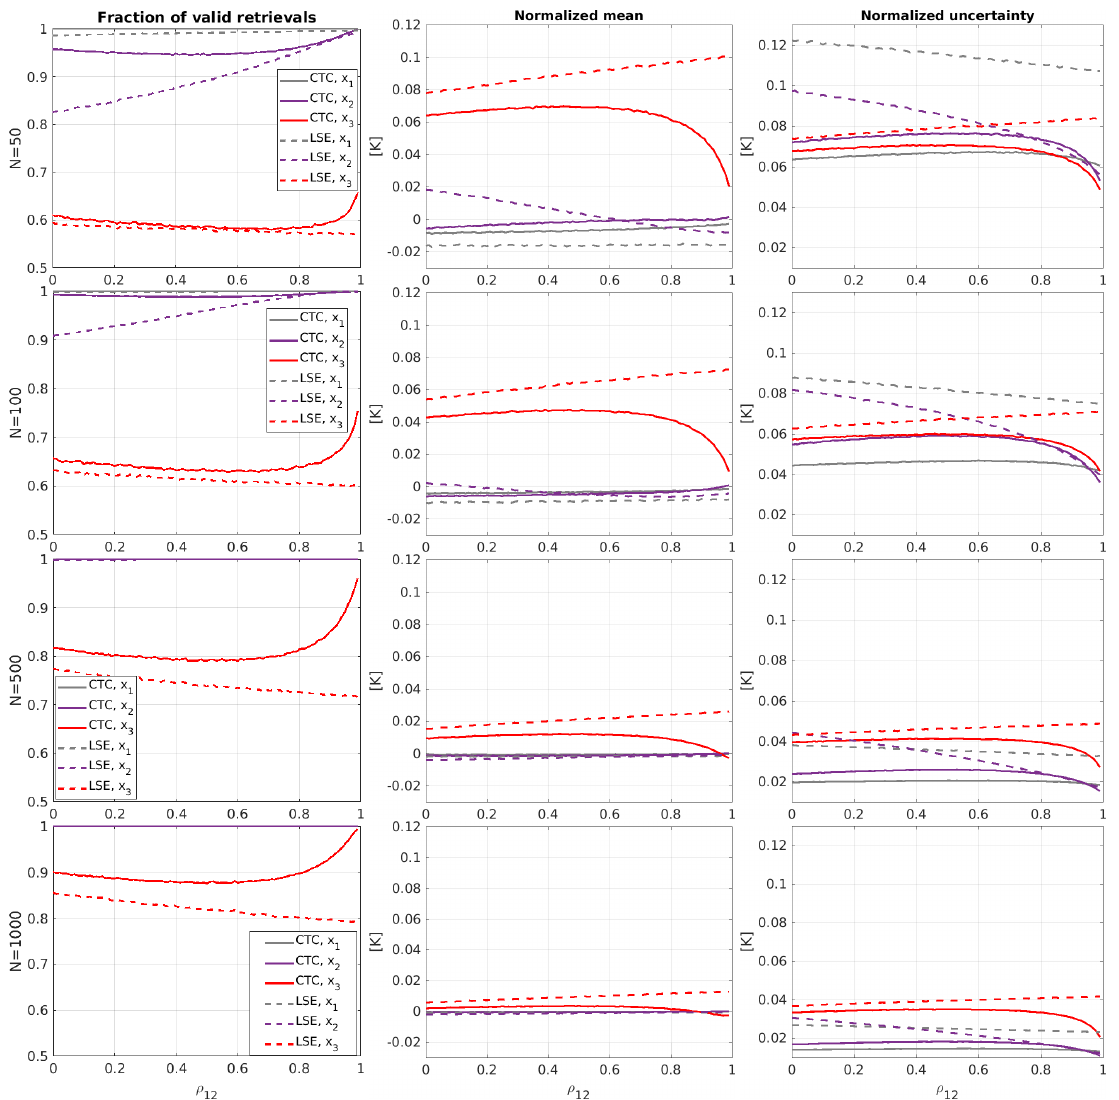
= 0.5, σ = 0.25, and σ = 0.1): δ 2 δ 3 1